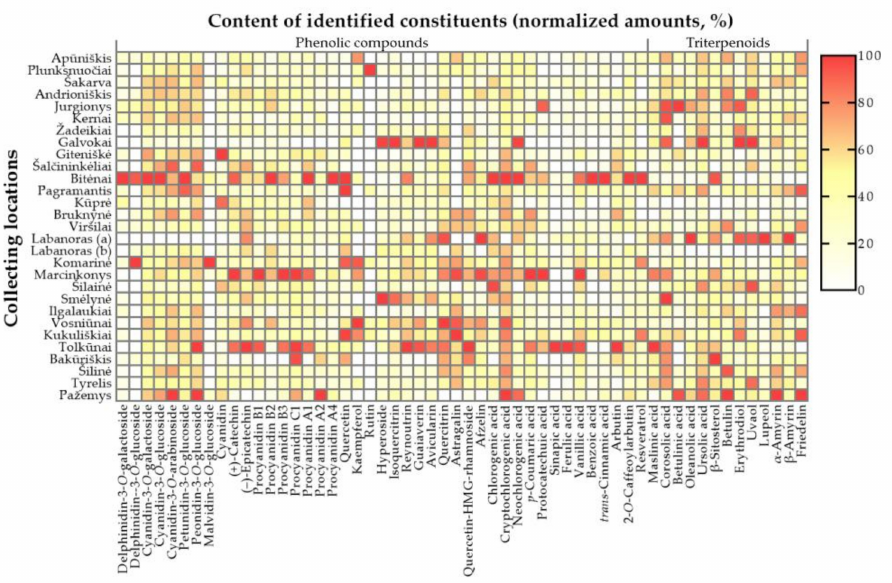
Figure 5. Heatmap estimating contents of individual constituents (%) in lingonberries based on their collecting locations. Anthocyanins contributed up to 24.7% of the total identified constituents in different samples. The greatest ( p < 0.05) levels of most anthocyanins were determined in Bit˙enai sample (7654.1 µ g/g DW), followed by Gitenišk˙e, and Pažemys samples. Besides habitat- dependent differences, the profile of anthocyanins was also genotype-dependent;